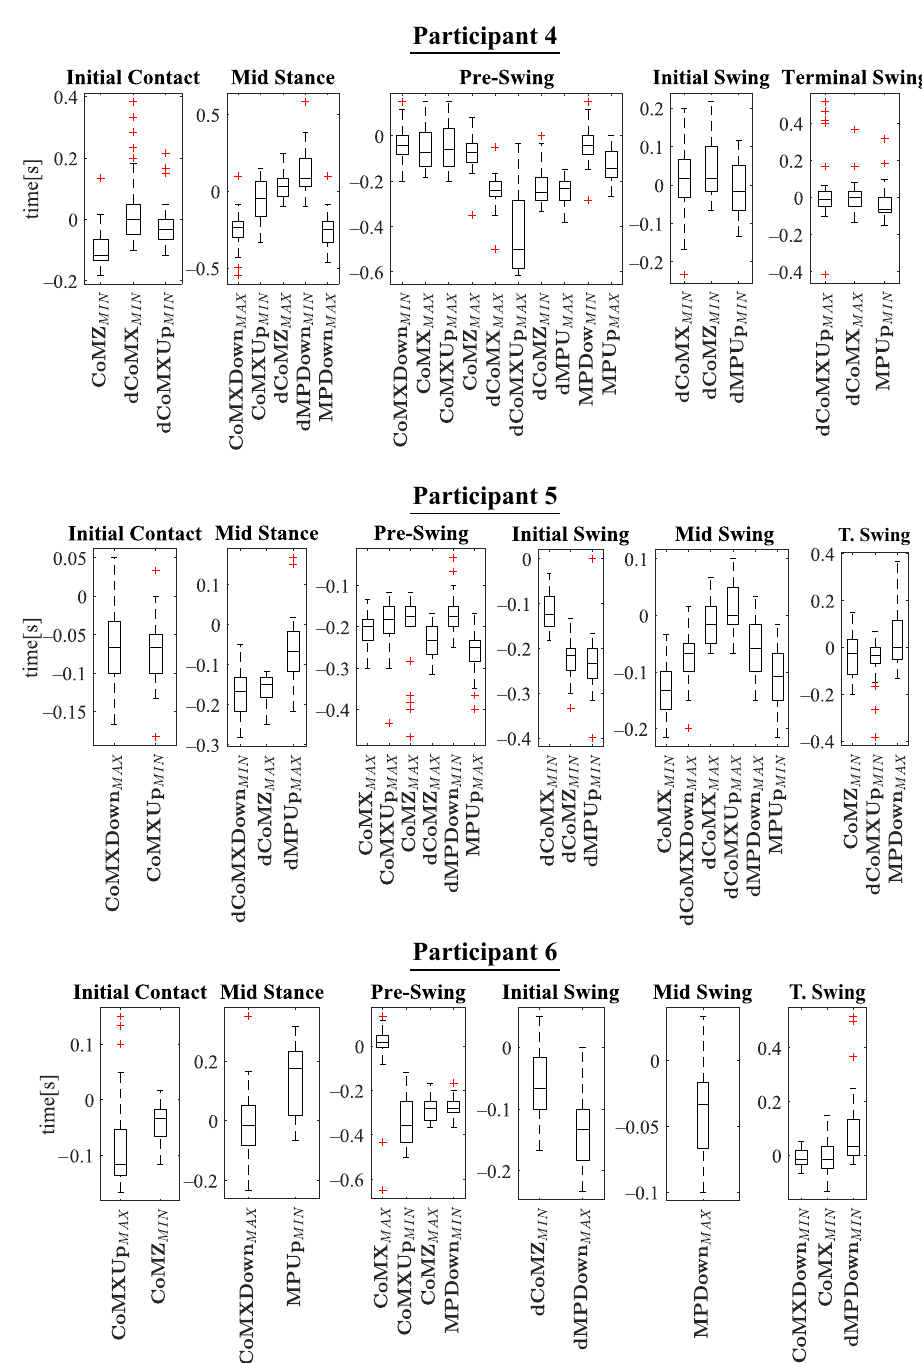
Figure 12. Experimental results for P4–P6. In the y -axis, 0 s is the time corresponding to the phase beginning. Negative time values mean that the event appears before the phase, and positive values that the it occurs after the phase has